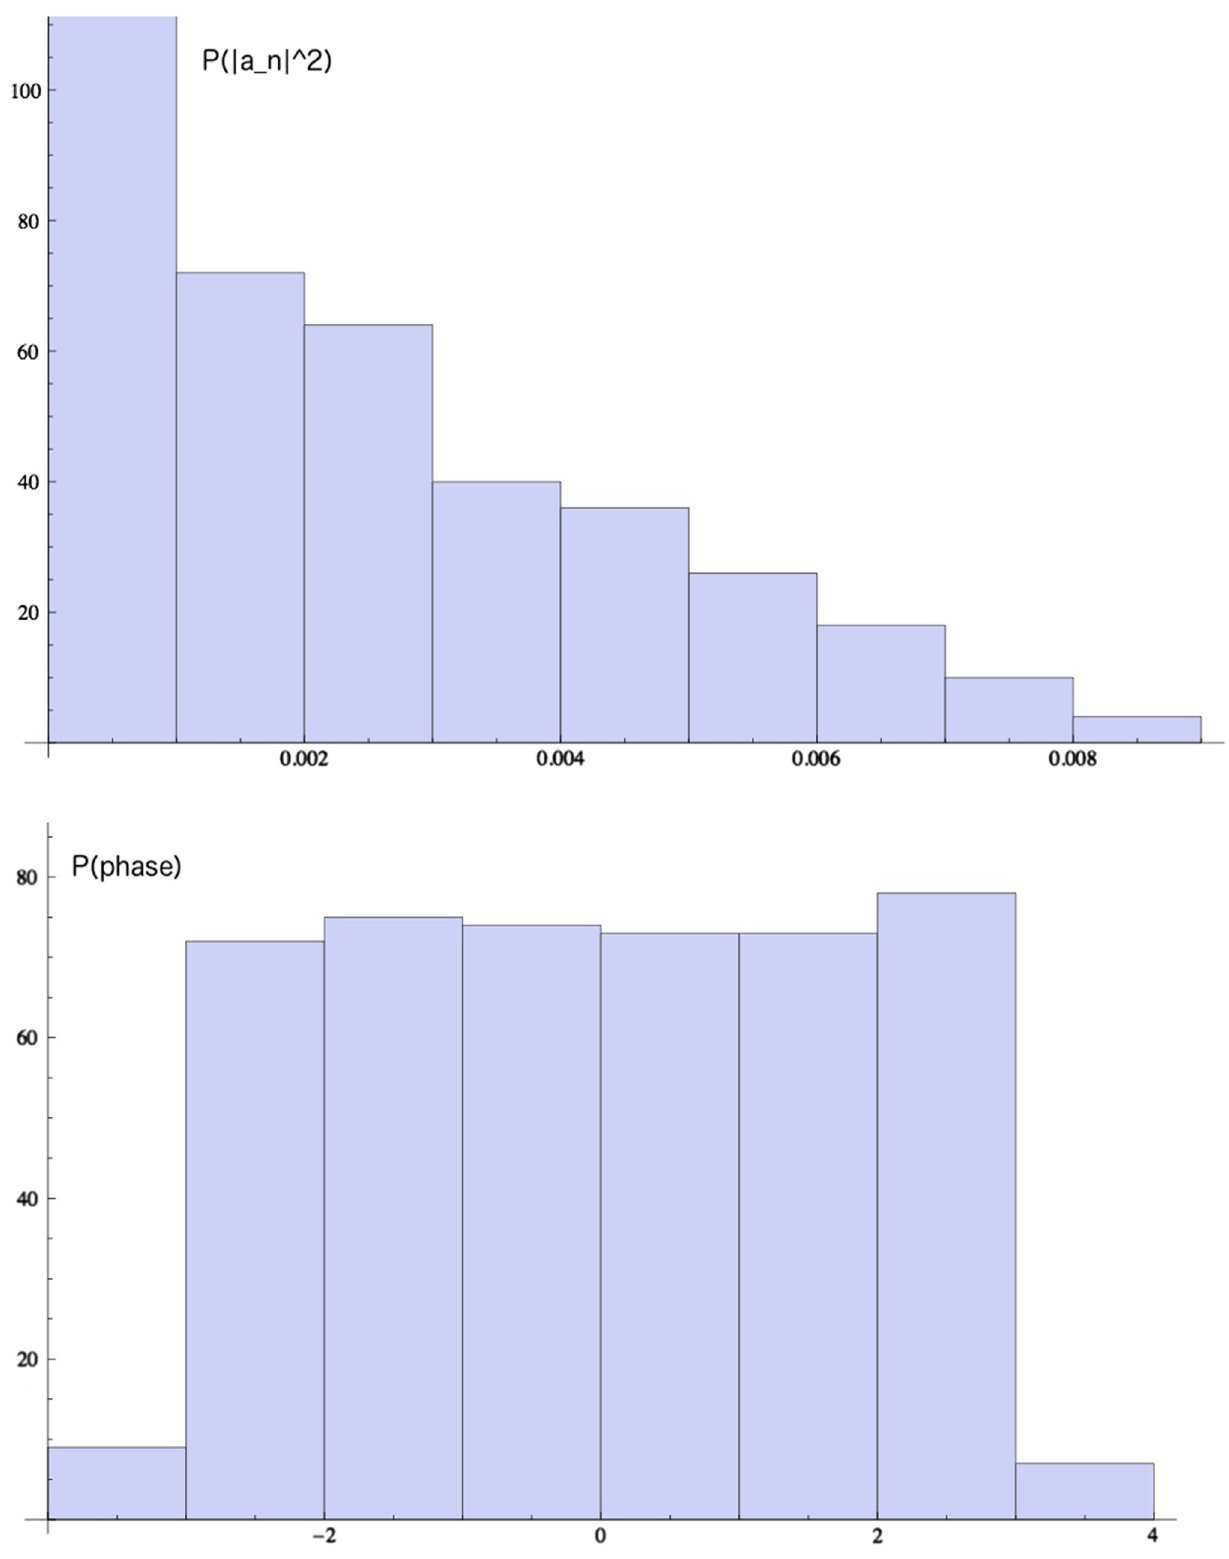
Fig. 5 The binned histograms for the squared amplitude, | a n | 2 , and for the (relative) phase of the amplitude in the ground state, for p =